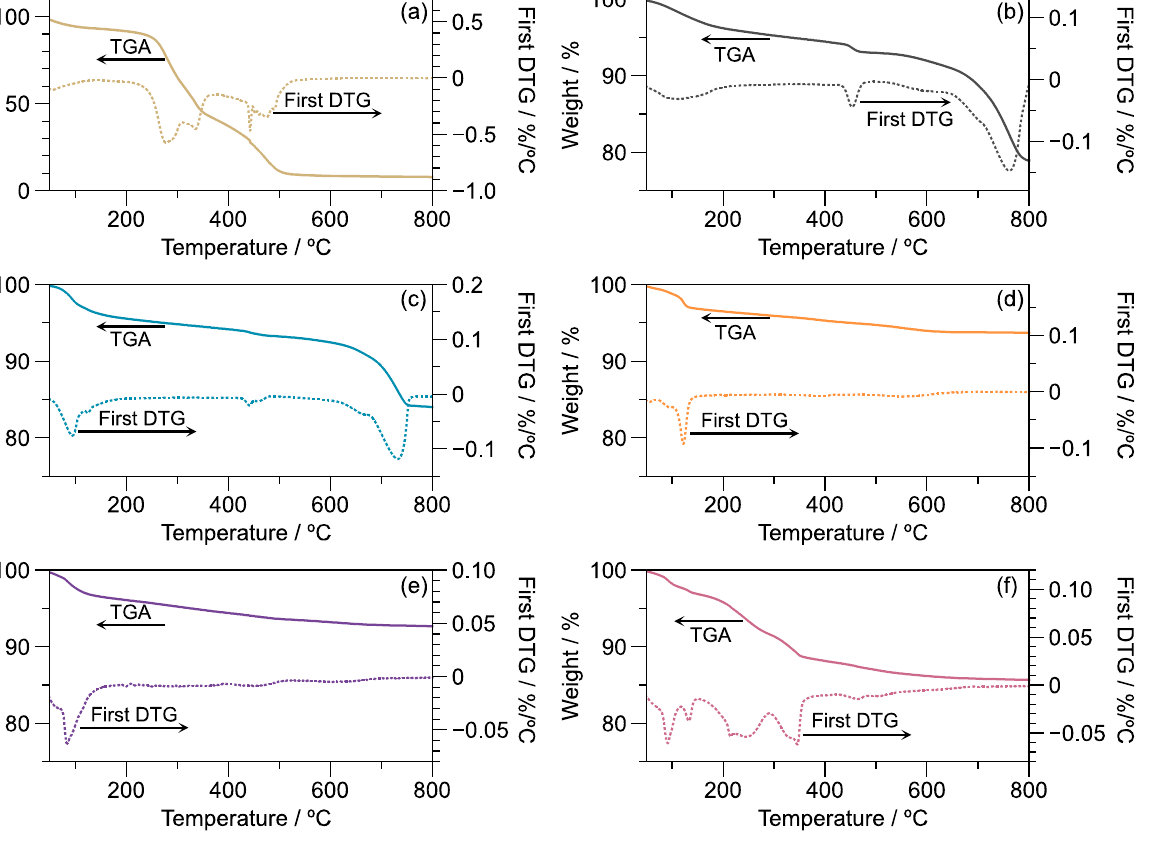
Figure 3. TGA and DTGA results of ( a ) WH, ( b ) WHA, ( c ) Geo 16M, ( d ) Geo 20M, ( e ) Geo 25M, and ( f ) Geo 30M.